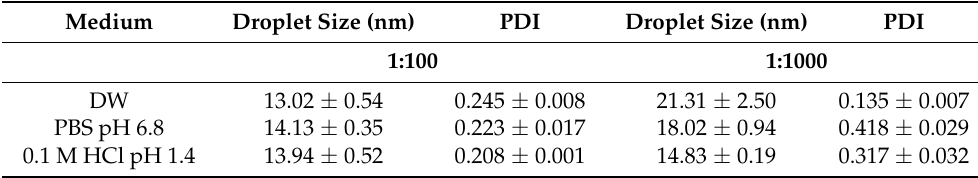
Table 9. Robustness to dilution and pH changes for L2